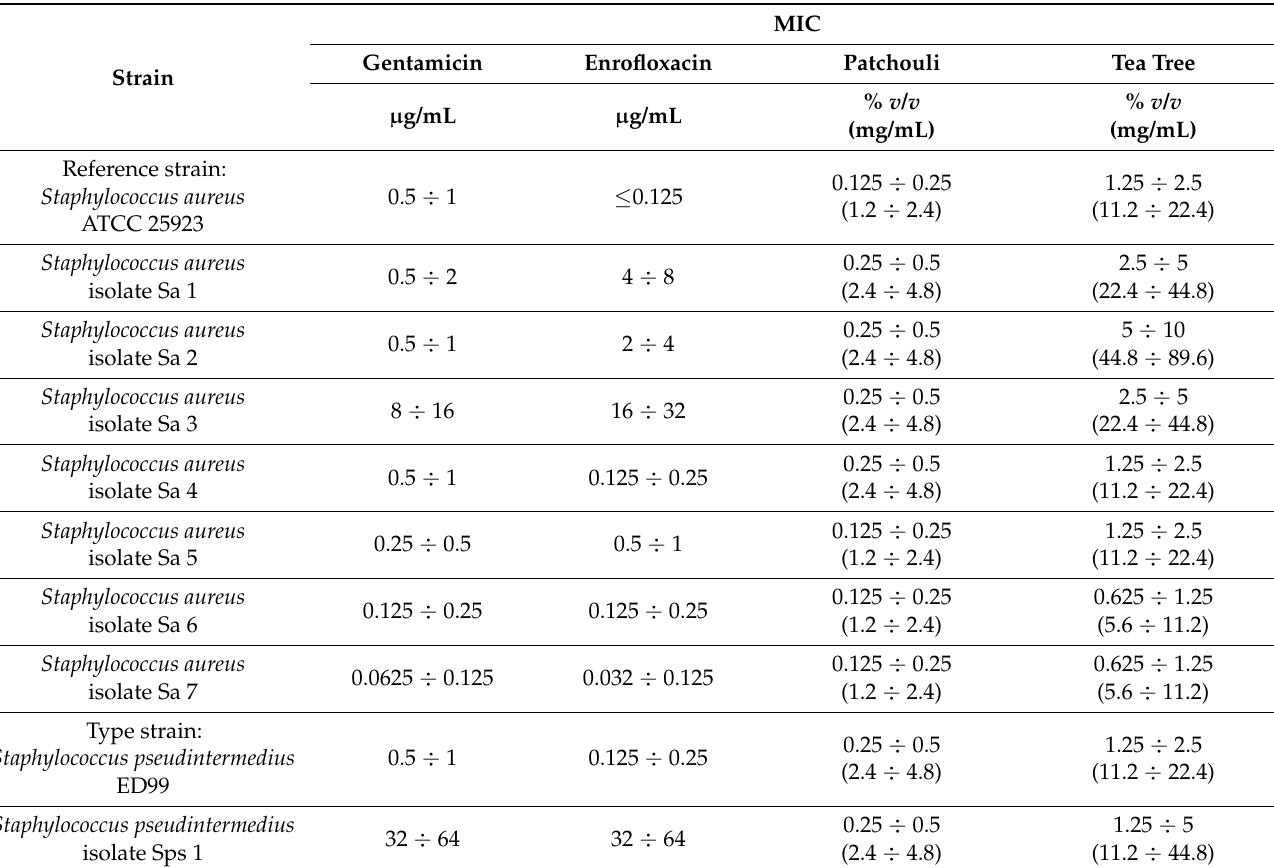
Table 2. Minimum inhibitory concentrations (MICs) of gentamicin, enrofloxacin, and both essential oils (PcEO and MaEO) against all S. pseudintermedius and S. aureus